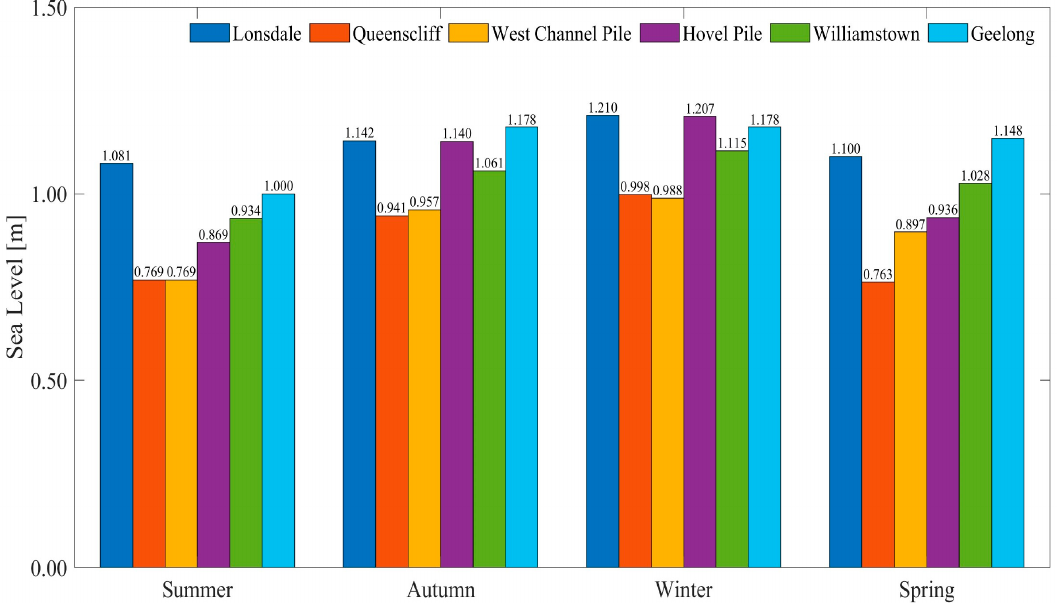
Figure 2. Estimated maximum water levels (AHD) at different stations based on hourly data from tidal gauges.